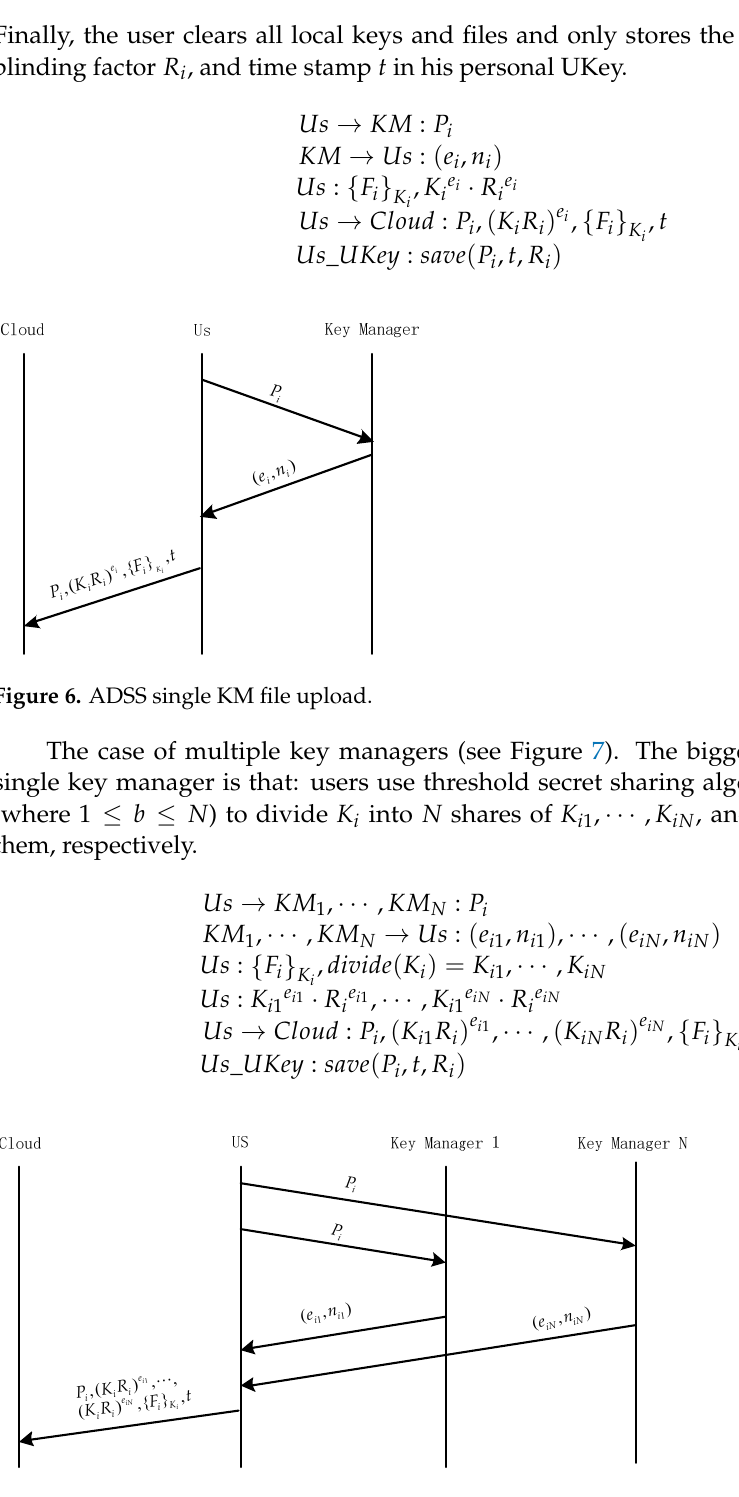
Figure 7. ADSS multi-KM file upload.